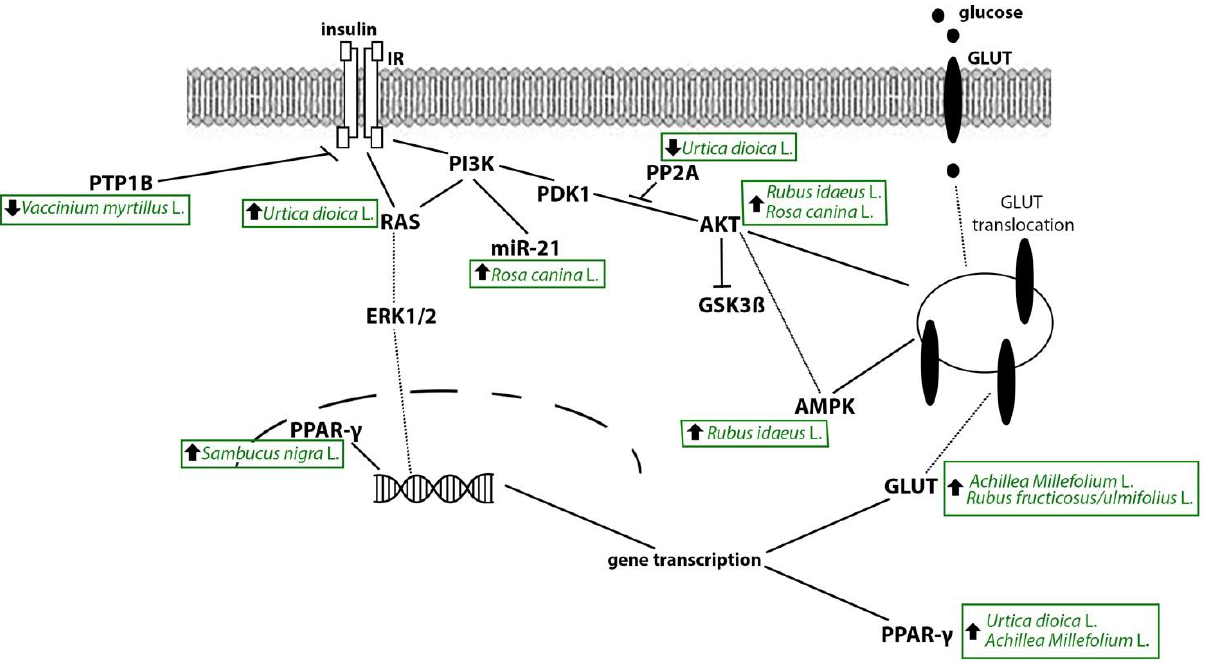
Figure 2. Plants used in the Occitan valleys of the Piedmont Alps: activation of the insulin signaling. According to the experimental evidence published between 2011 and 2021, the selected plants stimulate insulin signaling at different molecular levels. Their principal molecular targets are schematically represented. IR: insulin receptor; GLUT: glucose transporter; PTP1B: protein tyrosine phosphatase 1B; RAS: rat sarcoma; ERK1/2: extracellular signal-regulated kinase 1/2; PI3K: phosphoinositide 3-kinases; PDK1: phosphoinositide-dependent kinase-1; PP2A: protein phosphatase 2A; AKT: protein kinase B; GSK-3 β : glycogen synthase kinase-3 β ; PPAR- γ: peroxisome proliferator-activated receptor- γ; AMPK: AMP -activated protein kinase.